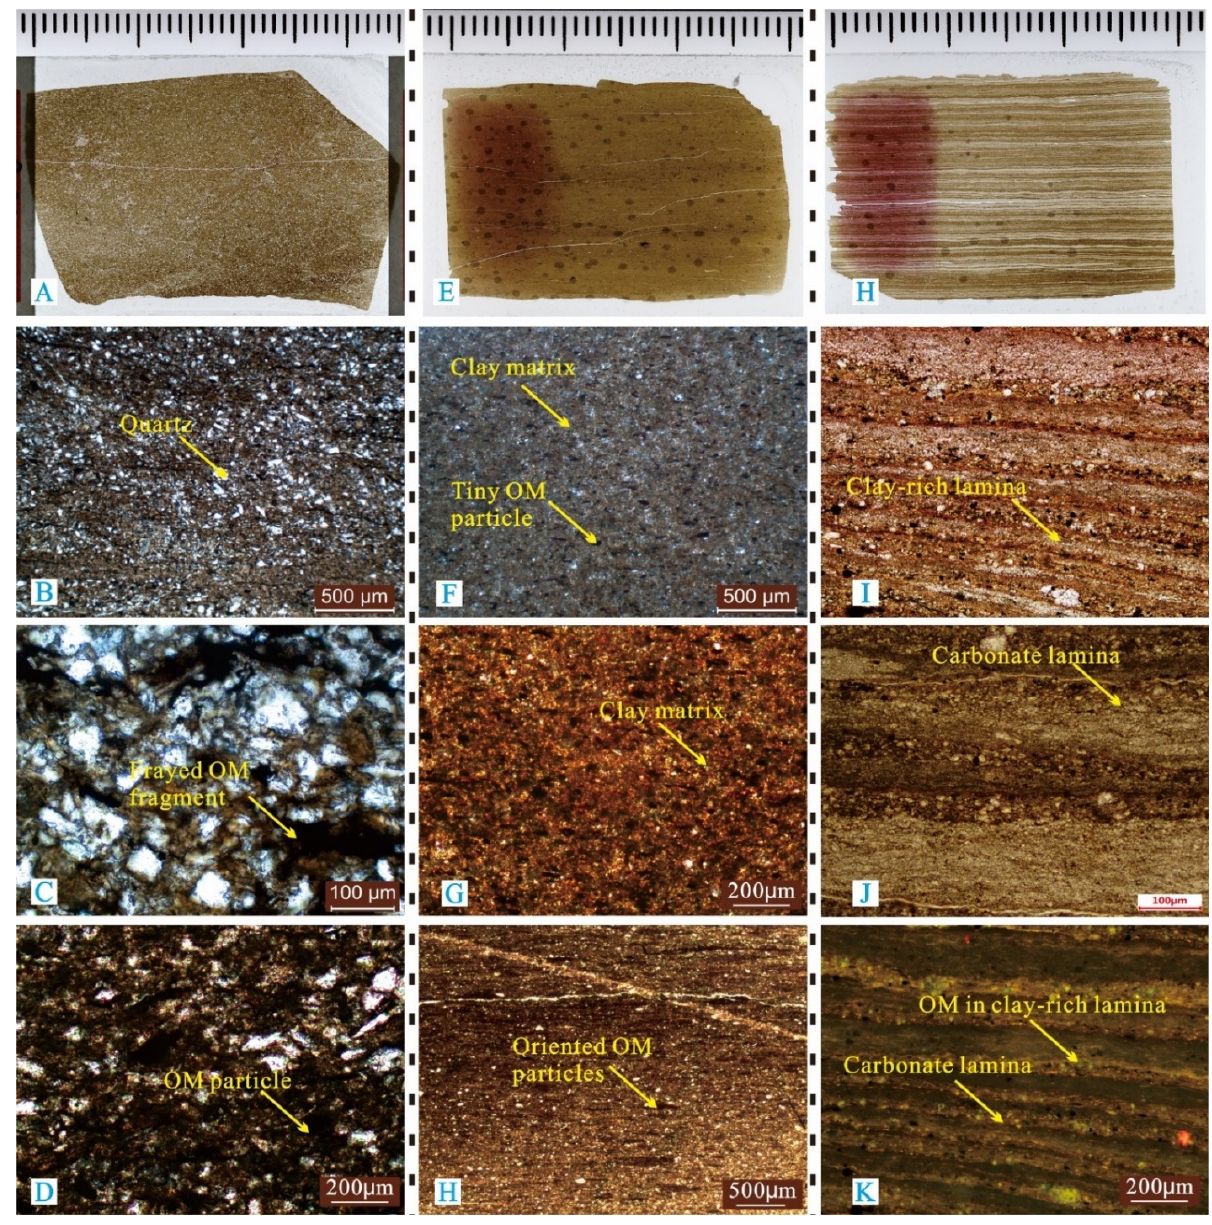
Figure 2. Photomicrographs of lithofacies characteristics of the mudrocks from the Dongpu Sag. ( A,E,H ) Scanned thin sections of the three lithofacies; ( B,C,D ) detrital minerals and OM in silt-rich massive mudstone; ( F,G,H ) clay matrix and OM particles of the homogeneous massive mudstone; ( I,J ) clay-rich laminae and micrite laminae in the laminated mudstone; ( K ) the OM in clay-rich laminae under a fluorescence microscope.